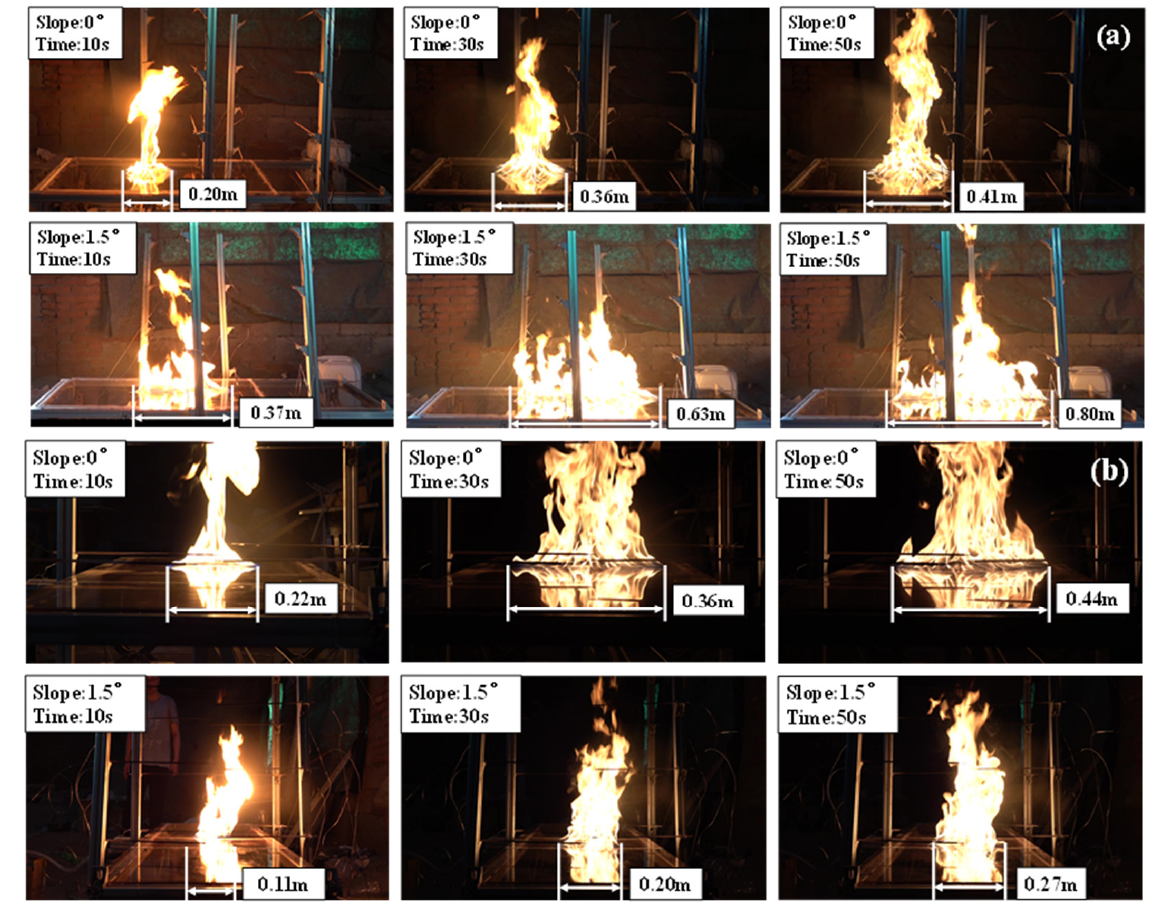
Figure 6. Experimental phenomenon of spill fire under different slopes. ( a ) Record from side direction. ( b ) Record from front direction.